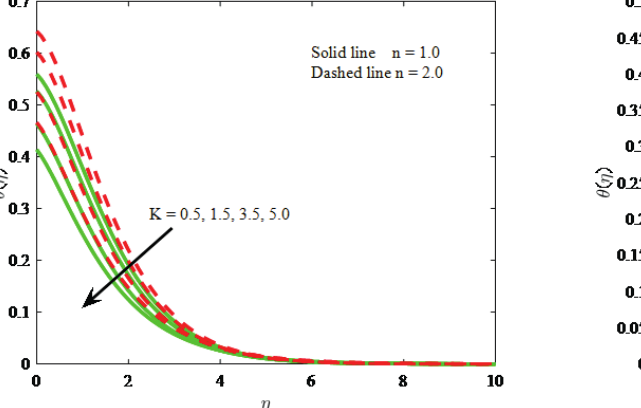
Fig. 7: Impact of K on temperature.